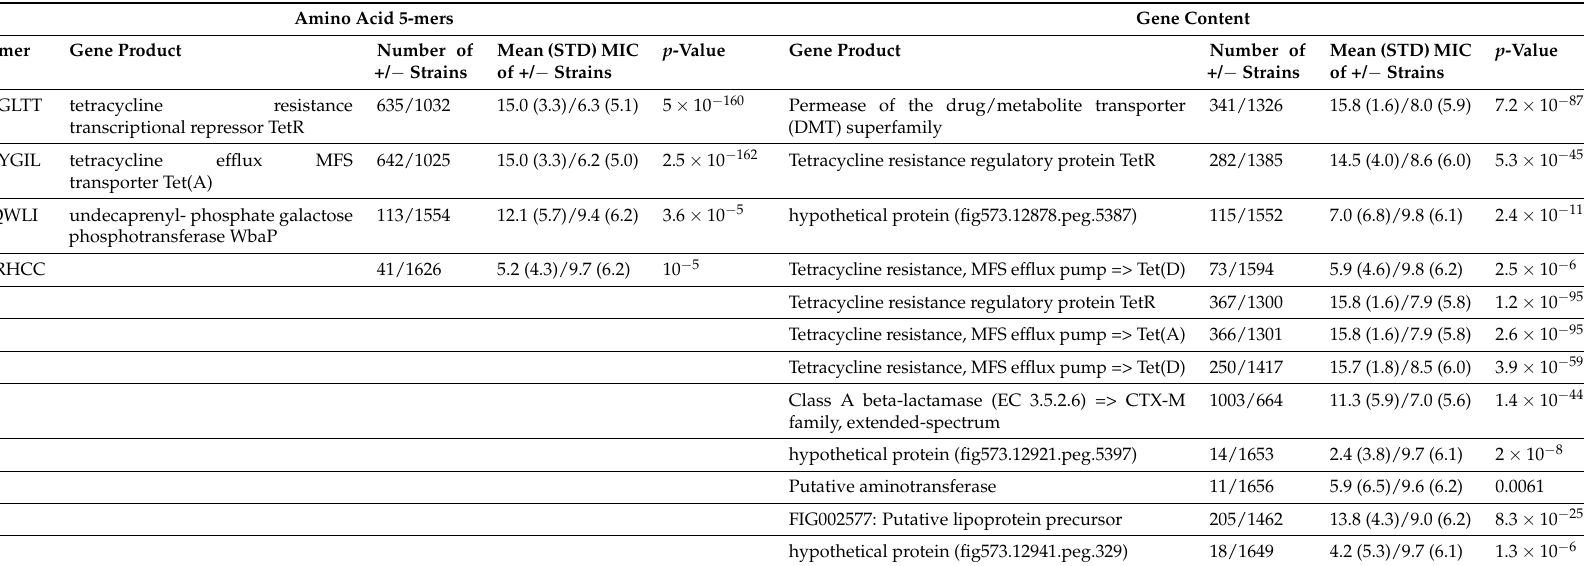
Table A5. Important features found for K. pneumoniae and tetracycline by amino acid 5-mer and gene content